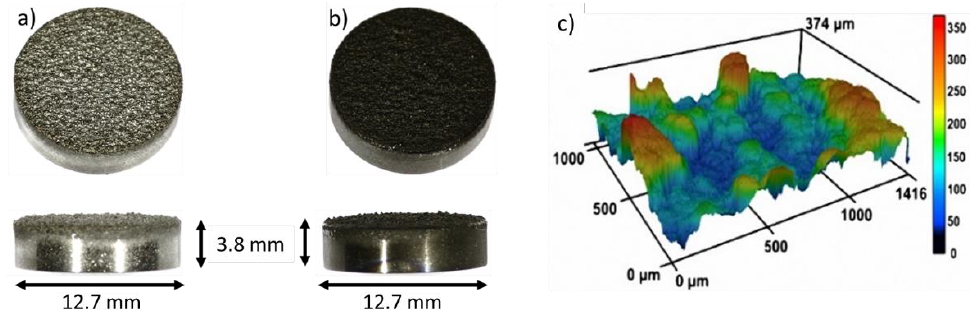
Figure 1. TiAl6V4 cylinders coated on one side with ( a ) 250 µ m TPS and ( b ) with 250 µ m TPS plus an additional GLAD Ti nanostructure (TPS+). In ( c ) a 3D image of the rough surface of the TPS sample measured with CLSM is